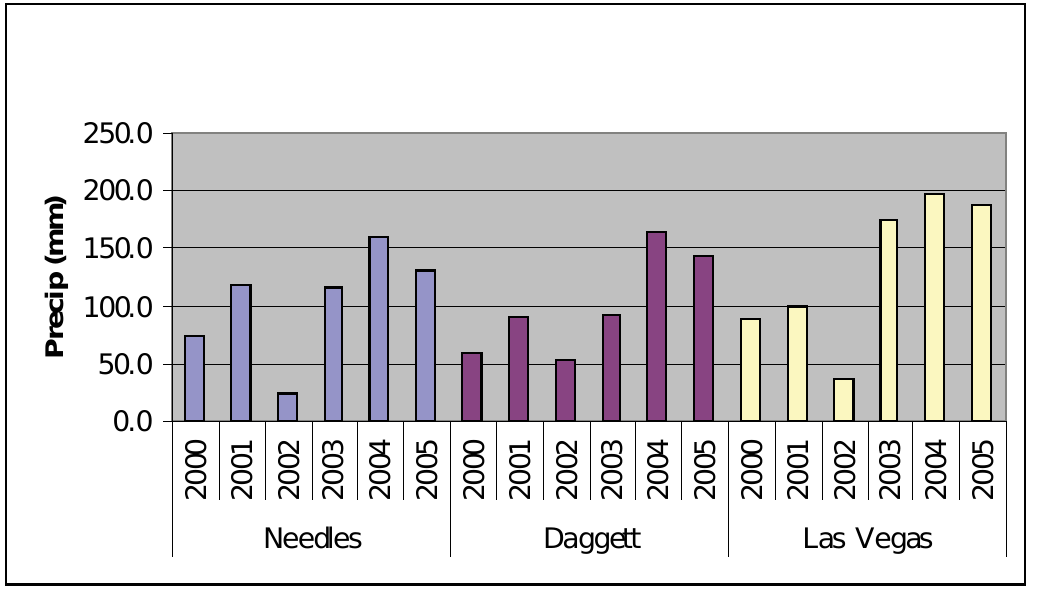
Figure 2. Annual precipitation recorded at three geographically isolated weather stations from 2000 to 2005 within the Mojave Desert. Both the temporal and spatial variability of precipitation are illustrated. The weather stations represent landforms and elevations where desert tortoise habitat is expected within the Mojave with Needles at 288 m, Dagget 588 m, and Las Vegas 658 m. The year 2002 was particularly dry while 2004 and 2005 had high annual precipitation. (Data source: Western Regional Climate Center,